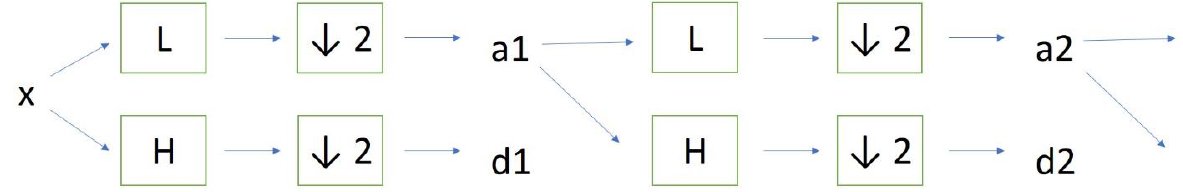
Figure 2. Process of a cascade of filterings during DWT analysis.